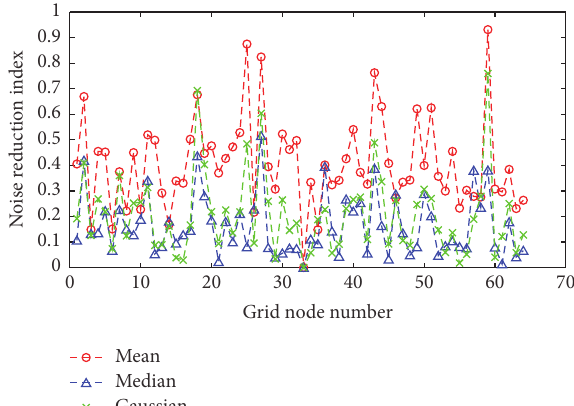
Figure 19: Eccentricity values of flow displacements using different image filters with reference being the baseline unfiltered image